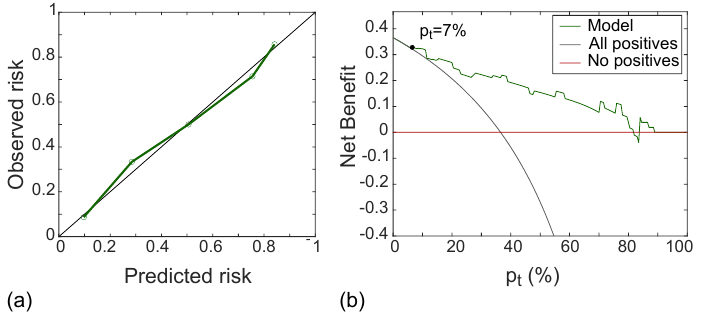
Figure 10. Calibration line ( a ) yielding p -value at Hosmer–Lemeshow test equals to 0.558 and DCA ( b ) with a net benefit of 32% at p t = 7%, referred to the test